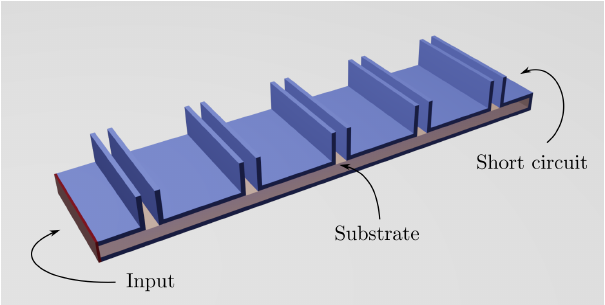
Figure 1. Array of open-circuited CTSs in resonant configuration.